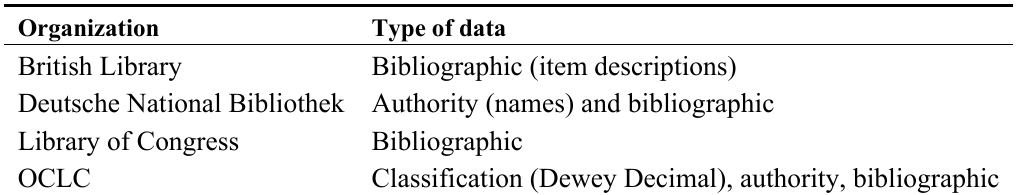
Table 1. Examples of linked